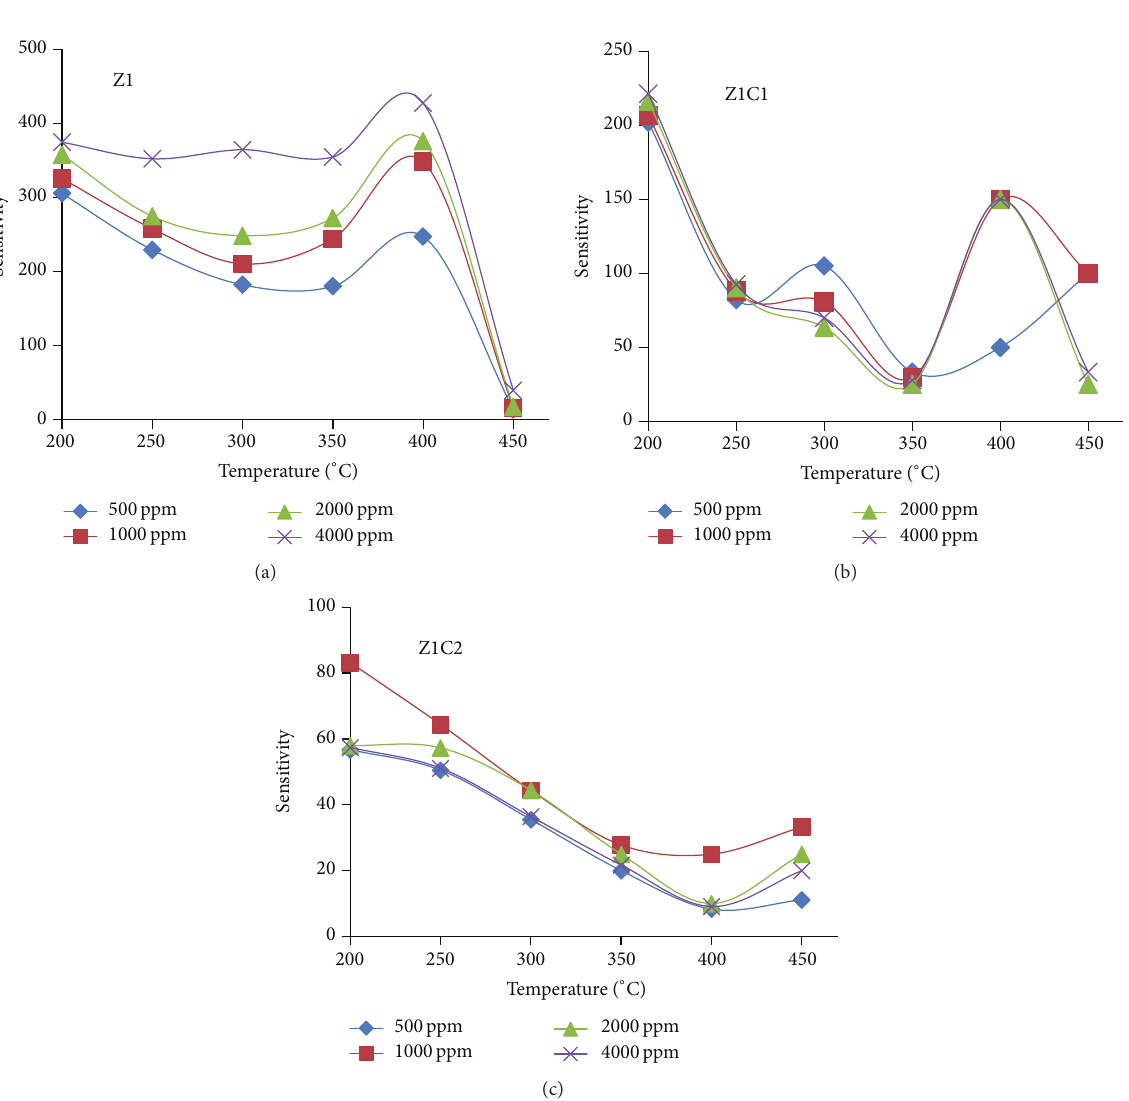
Figure 8: Variation of sensitivity of undoped and Cu doped ZnO thin film samples at various CO 2 concentrations with temperature. Here (a), (b), and (c) correspond to samples Z1, Z1C1, and Z1C2, respectively, prepared using precursor solution of molarity of 0.1